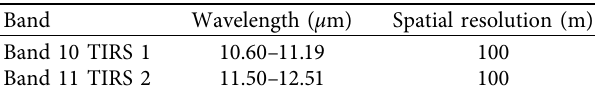
Figure 2: (a) The study of regional road networks in 2013 and (b) the study of regional road networks in 2018. Table 1: Wavelengths of the two Landsat TIRS.